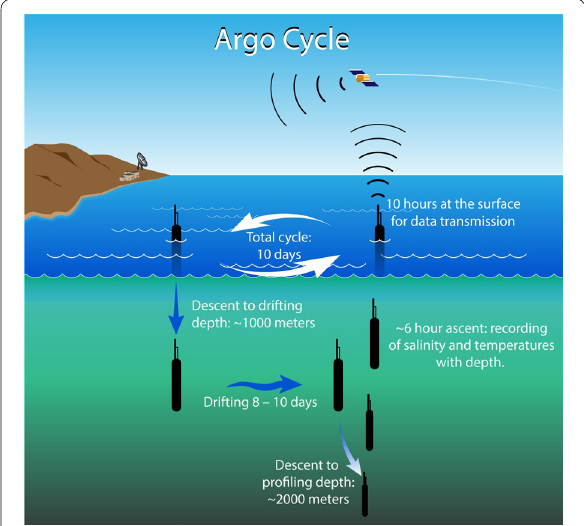
Figure 4 Argo float distribution (Figure courtesy from Argo home page: http://www.argo.ucsd.edu/)